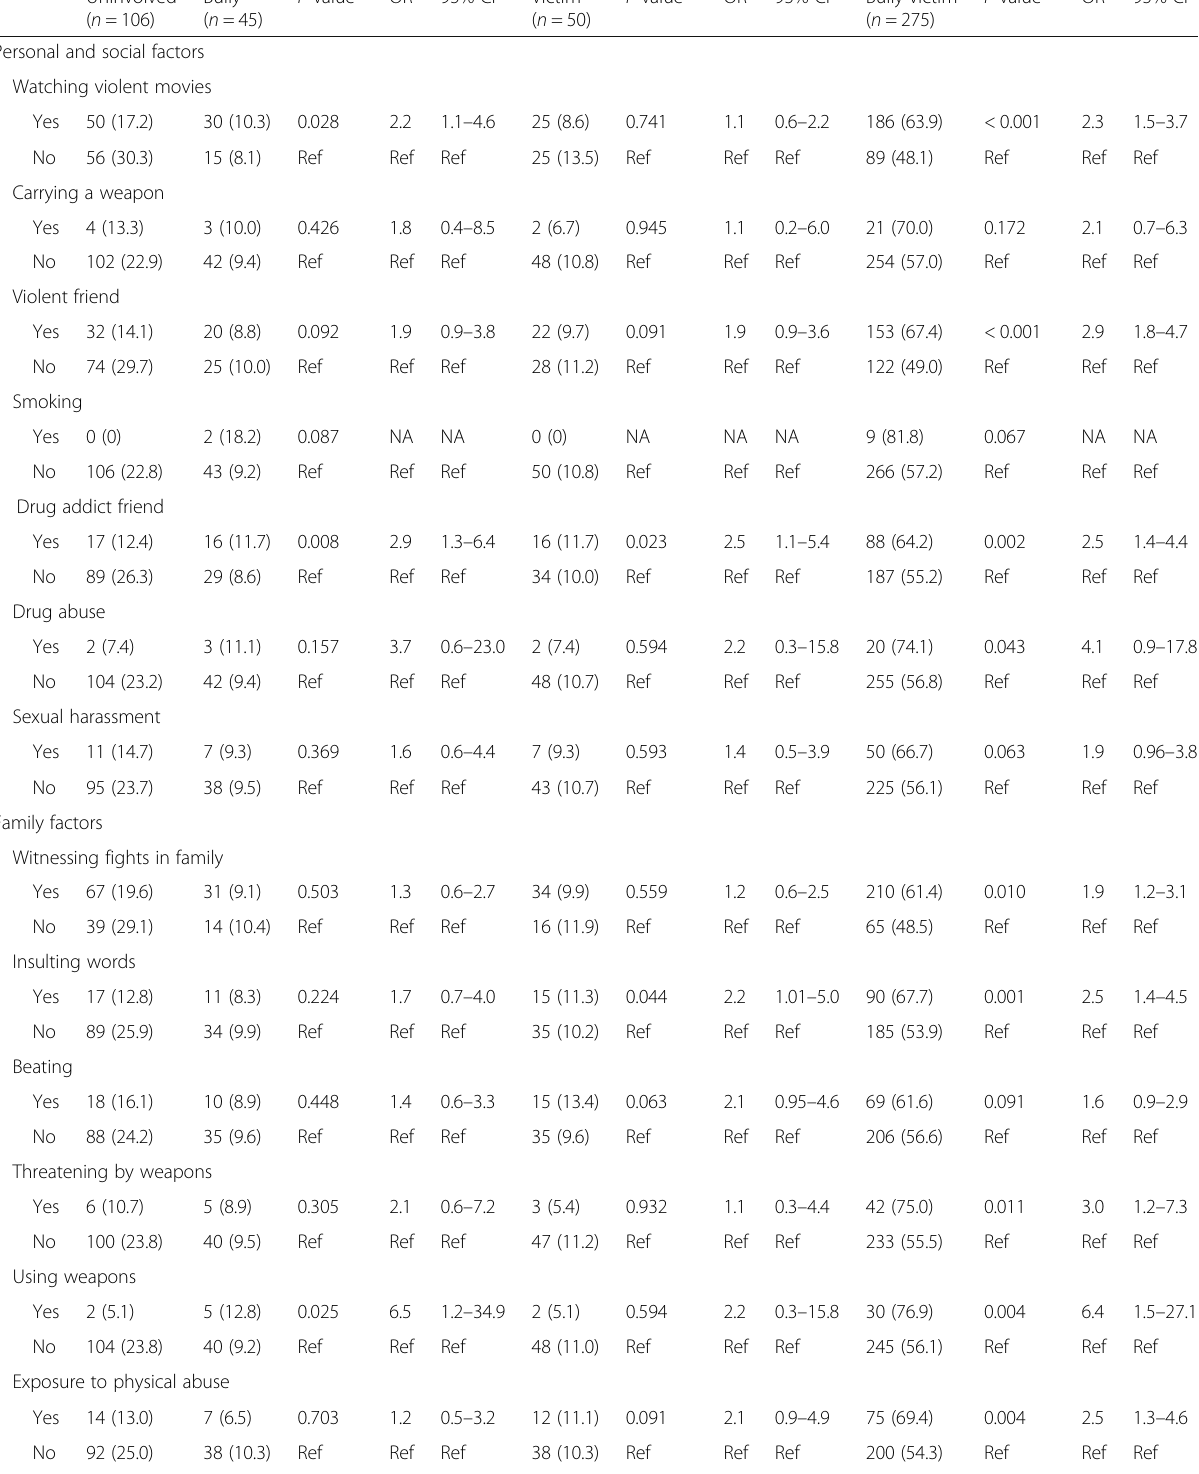
Table 2 Personal and family factors associated with bullying behavior among the studied